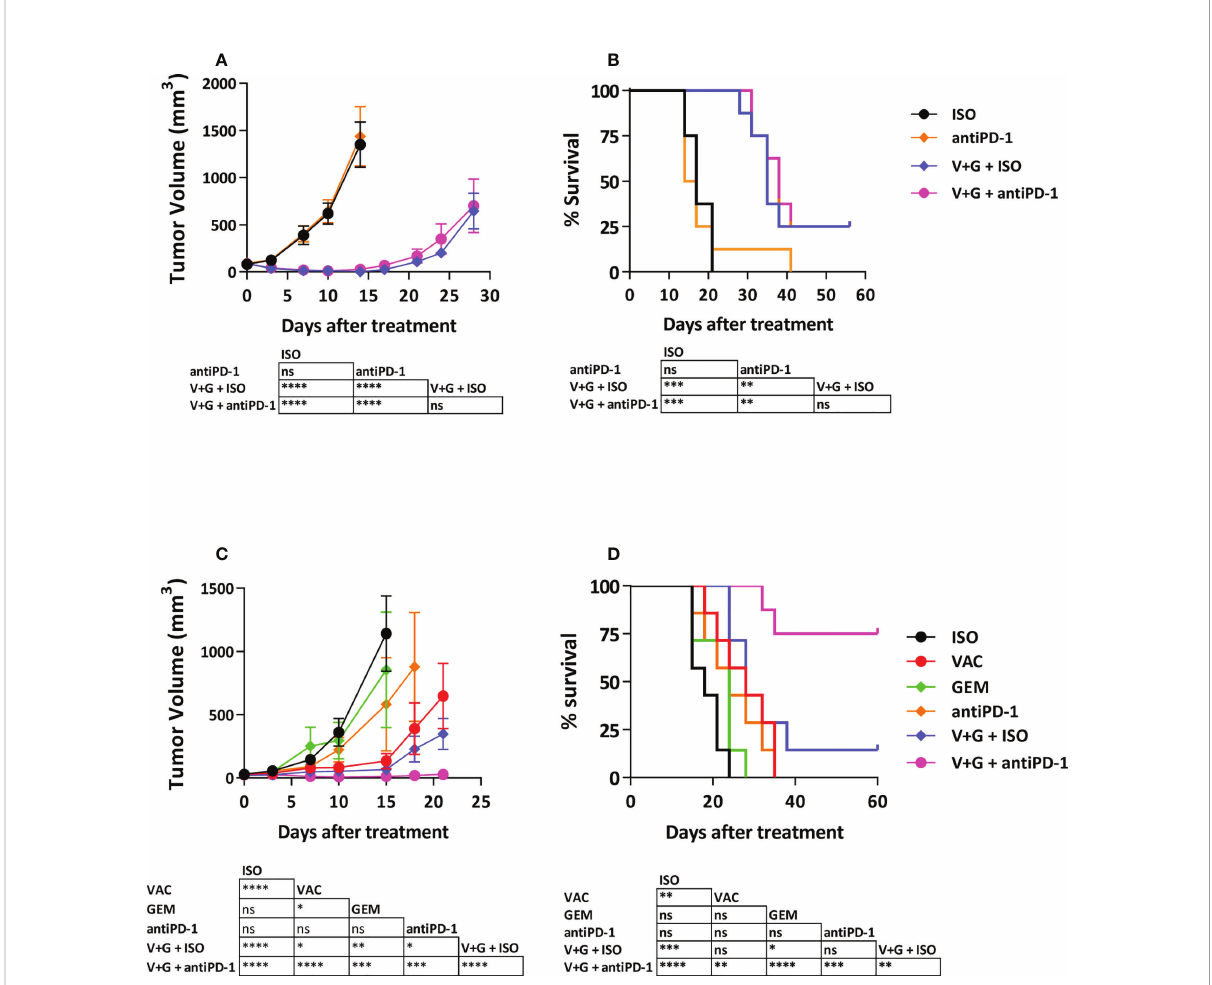
FIGURE 5 Antitumor ef fi cacy of the combination Vaccine + Gemcitabine with PD-1-blocking antibodies. C57BL/6J mice (n=7-8/group) with 5-6 mm LLC-OVA (A, B) or B16-OVA (C, D) tumors were treated with different combinations of vaccine, gemcitabine, anti-PD-1 antibodies or isotype control antibodies. Tumor growth (A, C) and animal survival (B, D) were evaluated twice per week. (*P < 0.05; **P < 0.01; ***P < 0.001; ****P < 0.0001). ns, non signi fi